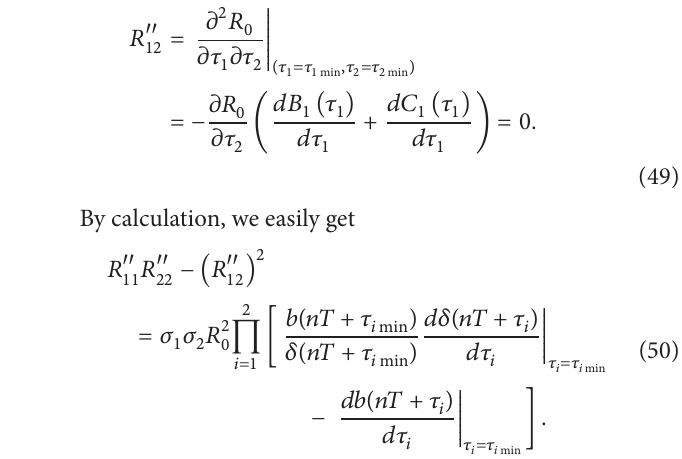
= 0.25 , 1 𝑝 𝑅 1 on 0 ;